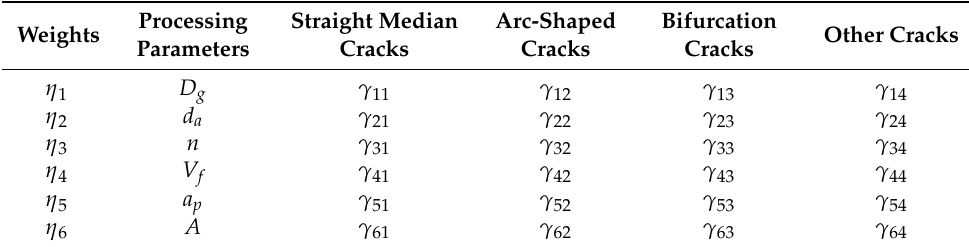
Table 3. Influence strength names and grey relevance of process parameters to subsurface crack forms.